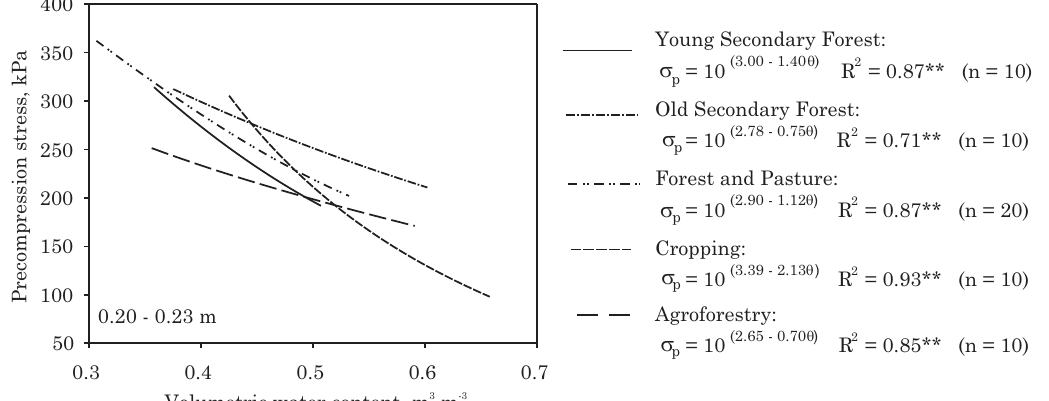
Figure 4. Load bearing capacity models for a Cambisol at 0.20 - 0.23 m depth under different land use